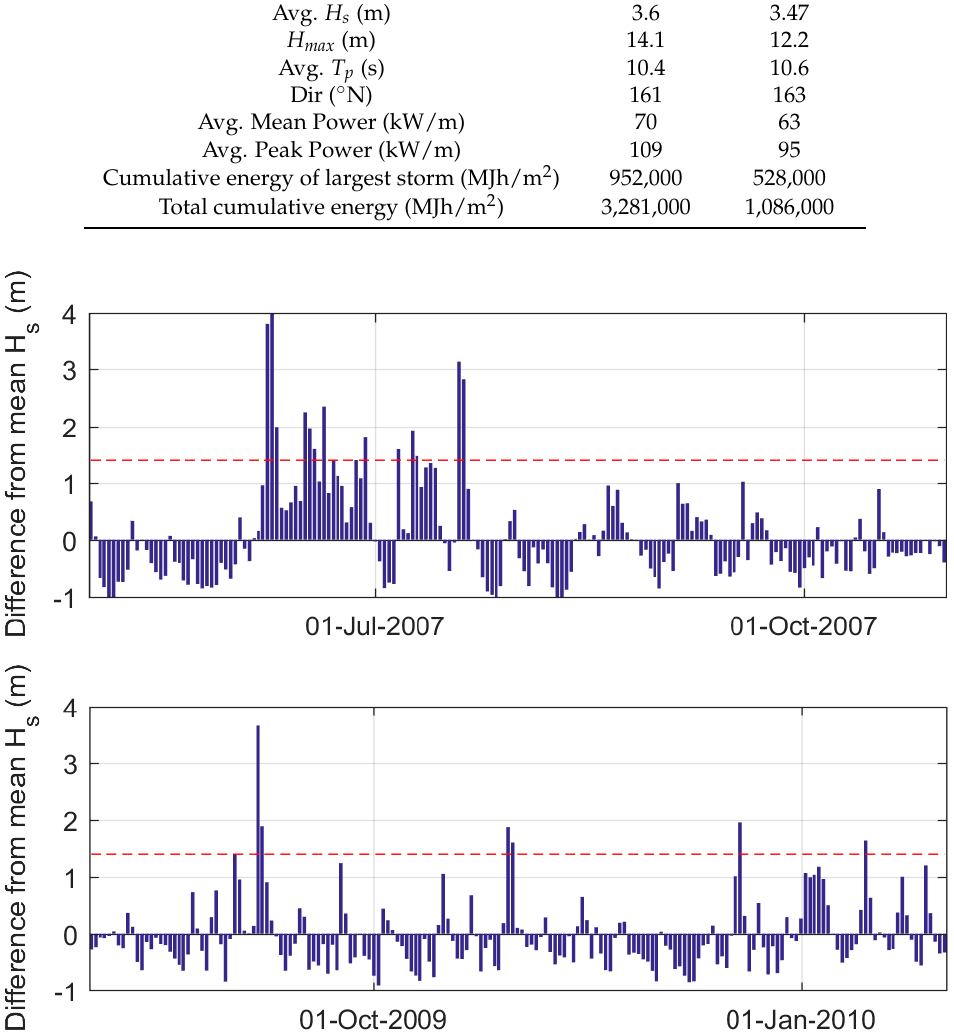
Figure 3. Daily H s difference to mean H s (1.6 m) for the six months prior to each of the bathymetric surveys. The dashed line represents the threshold for storm conditions at the study site (H s = 3